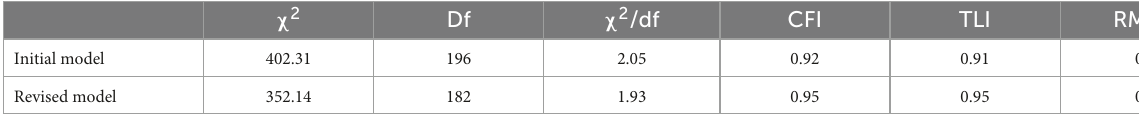
TABLE 3 Fit indices for the initial and revised models.